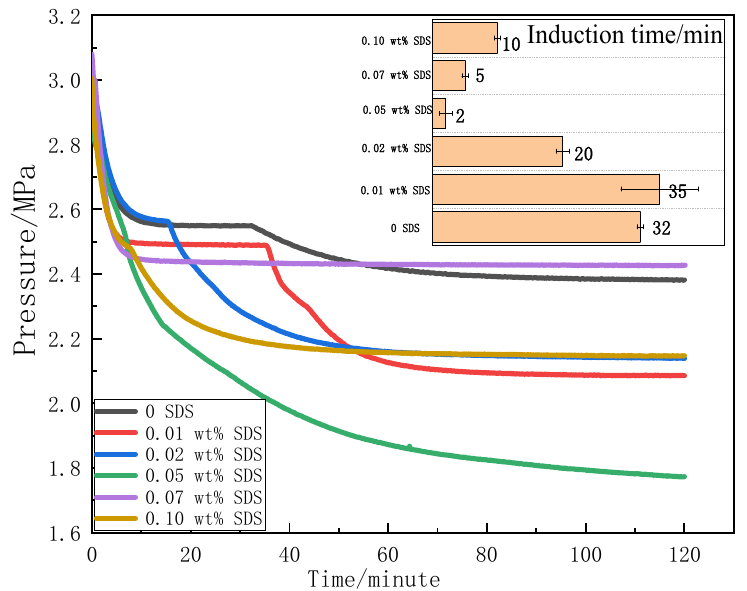
Figure 2. Pressure drop change induction time of hydrate formation in 3.5 wt.% NaCl + SDS solu- tion.